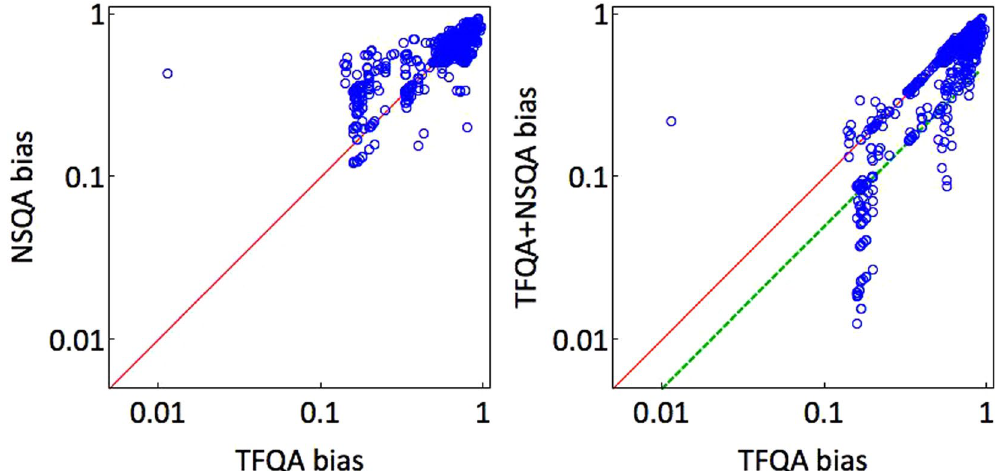
Figure 6. Scatter plots of biases of the tested instances’ quantum GSDs. Left: Biases of TFQA annealing vs. NSQA annealing showing that the non-stoquastic driver is slightly more biased in general than the transverse field driver (not shown in the figure are the completely unbiased instances which constitute about 57% of the instances). Right: Biases of the TFQA GSDs vs. those of the combined application of TFQA and NSQA indicating that use of an additional non-stoquastic driver considerably reduces the bias of the